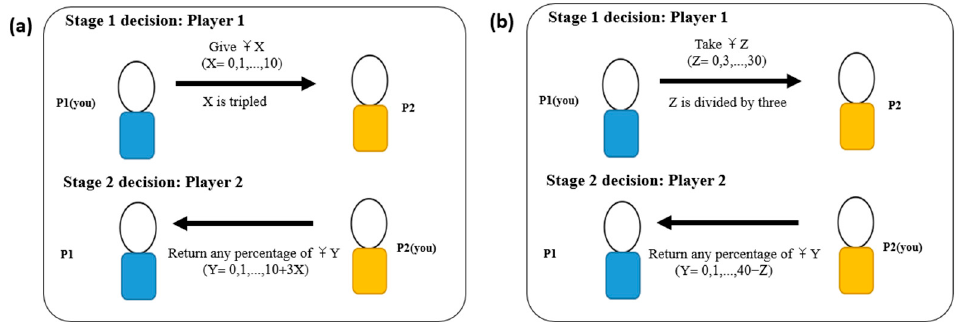
Figure 3. The trust and distrust game frameworks. ( a ) Trust game (TG). Both players received an initial endowment of Ұ 10. In the first stage, the trustors (Player 1) decided to give any amount of their endowment X to the trustees (Player 2). The amount would be tripled and sent to trustees. In the second stage, the trustees decided to return any percentage of the remaining money ( Ұ 10 + 3X) to the trustors. ( b ) Distrust game (DTG). Trustors were initially endowed with Ұ 0, and trustees with Ұ 40. In the first stage, trustors decided to take Z from trustees. Z was divided by three and sent to trustors. In the second stage, trustees decided to return any percentage of the remaining money ( Ұ 40-Z) to trustors.